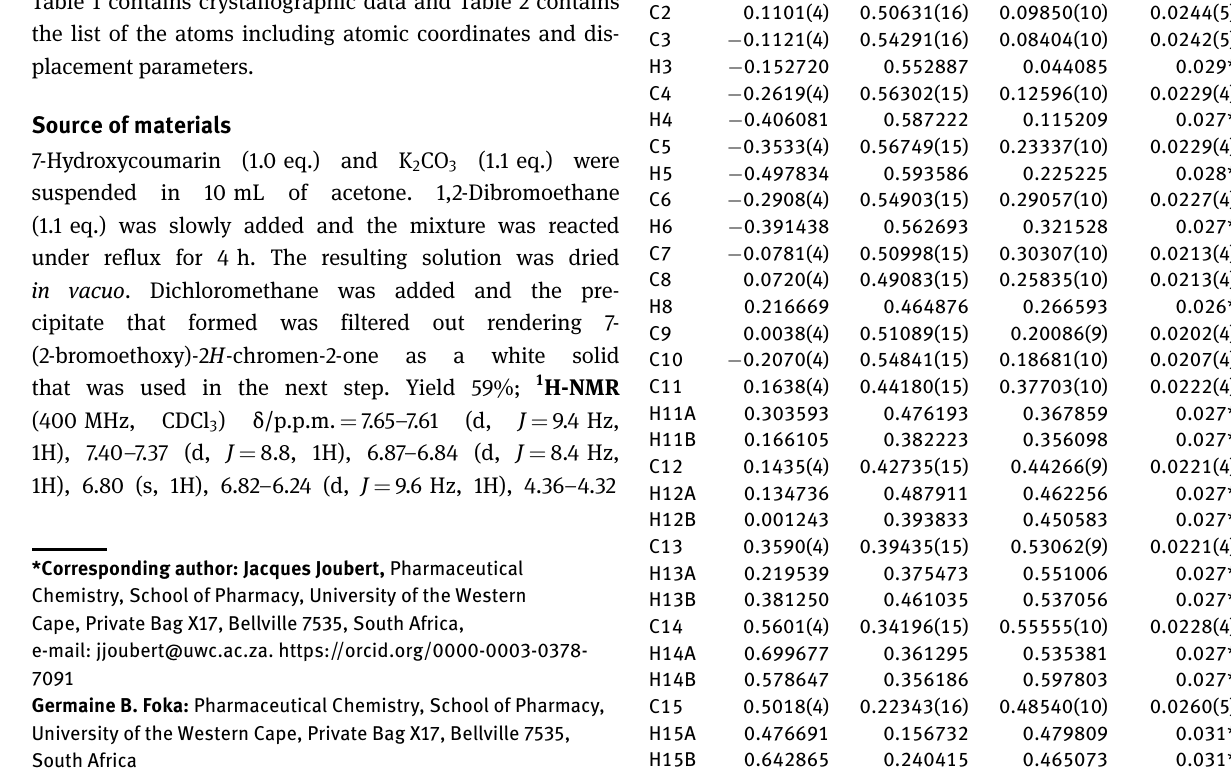
Table 1 contains crystallographic data and Table 2 contains the list of the atoms including atomic coordinates and dis- placement parameters.